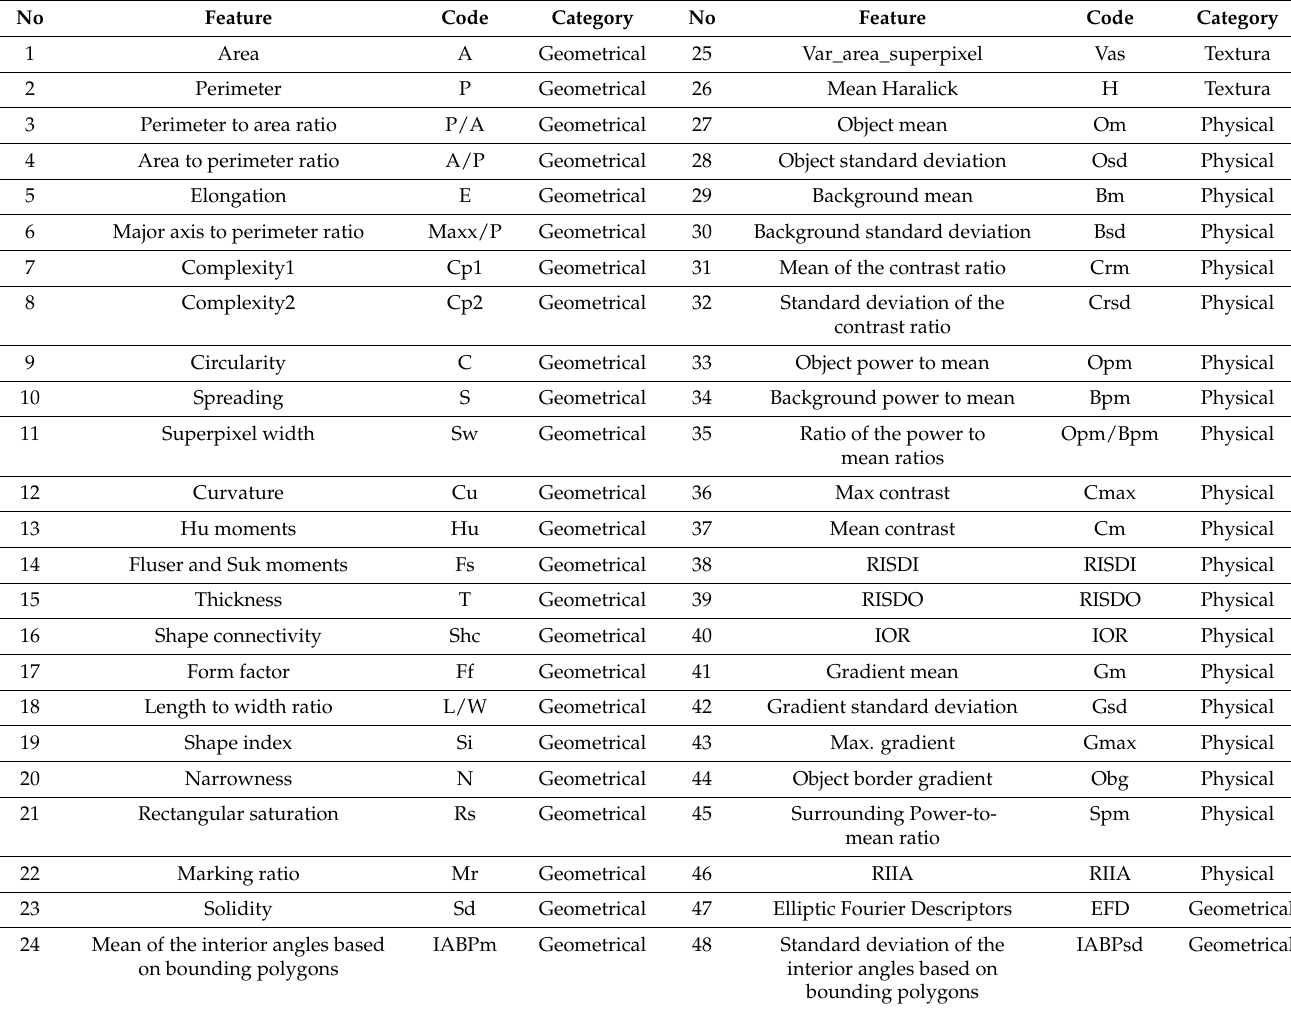
Table 1. Geometric, texture, and physical features computed for superpixels in this